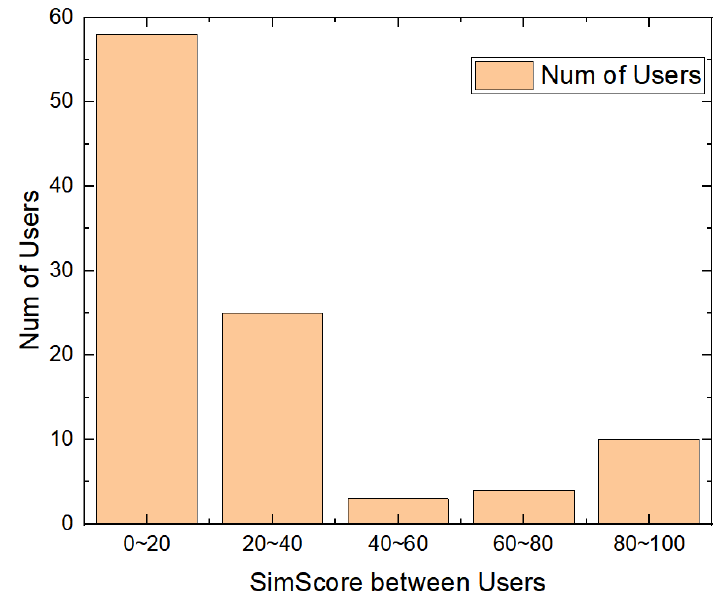
Figure 7. Similarity score between users. Table 6 lists users with scores higher than 80. Table 6. Top 10 users by similarity score.